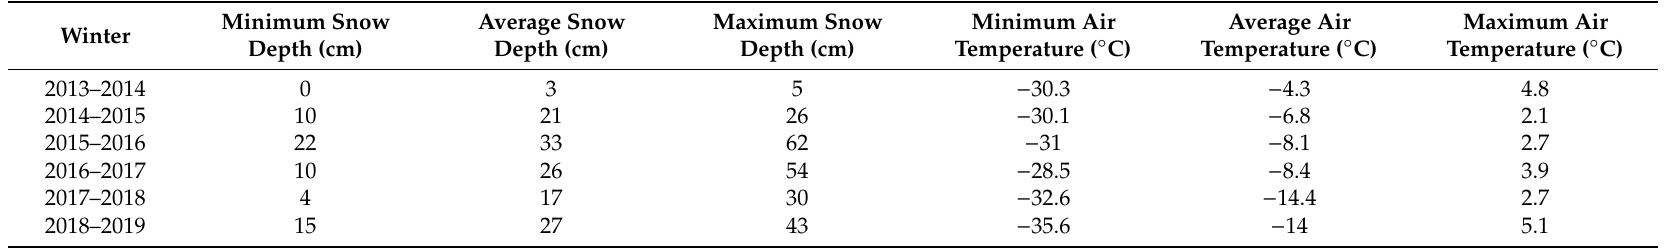
Table 2. The mid-winter (February) snow depths at Pulmanki study site based on field observations. The 2014 values were estimated based on pictures, as we did not have measurements from that mid-winter condition. Additionally, the min, max and average air temperatures (FMI’s data) of February of each year are